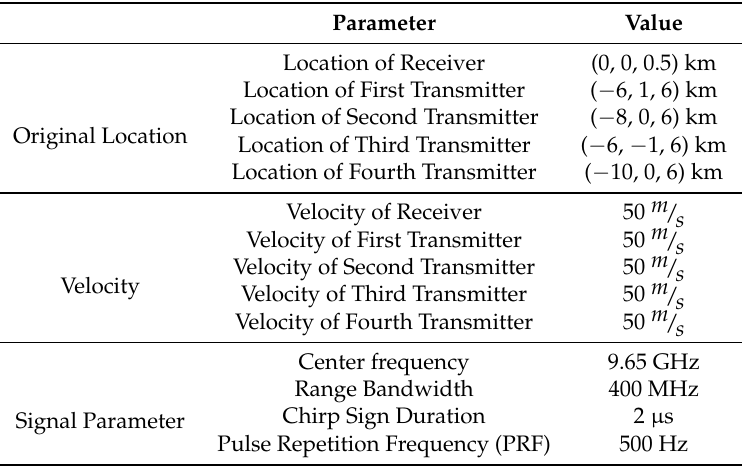
Figure 10. Target area used in the simulation. Table 1. Simulation